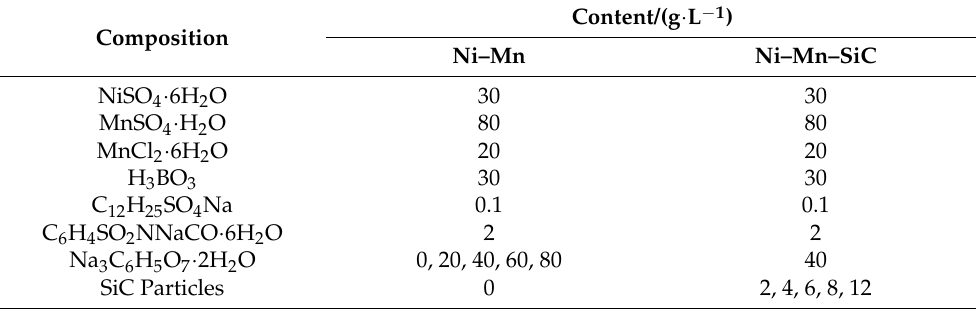
Table 1. Electrolyte